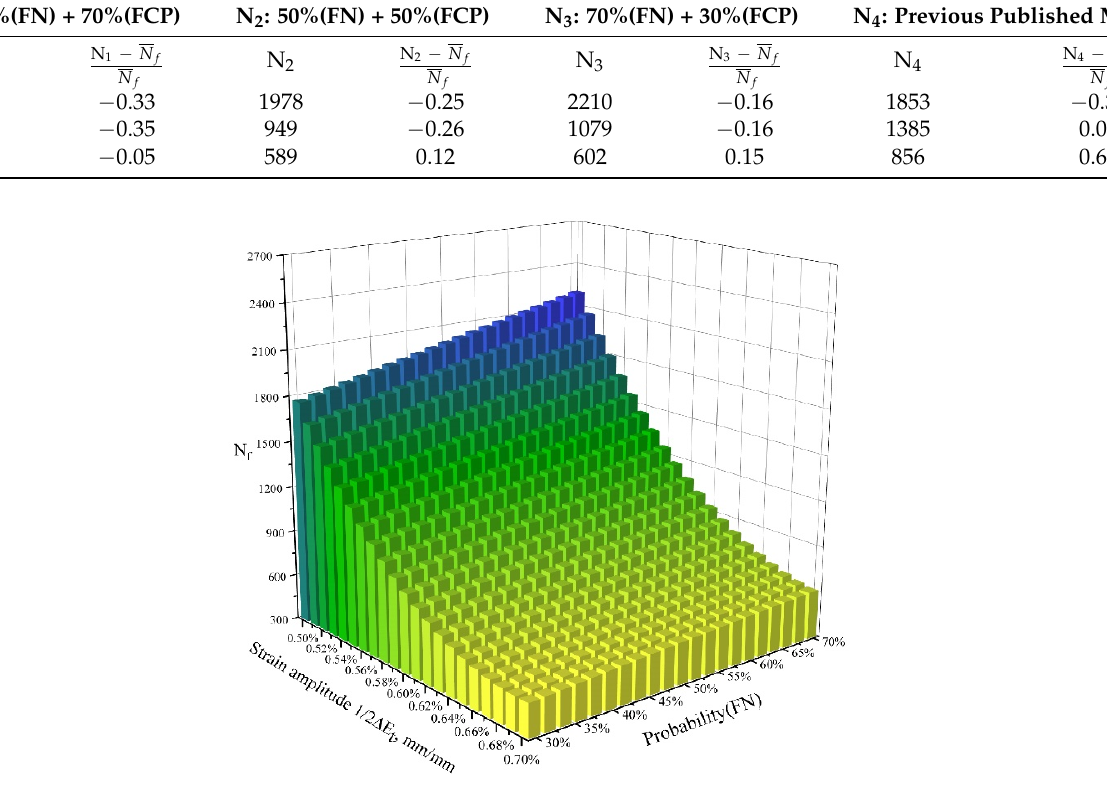
Figure 18. Comparisons between the experiments, predicted results using the proposed method under different probability combinations, and a previously published method based on the crystal plasticity (CP) theory. Table 5. Tested LCF lives of the UFG AA6061 vs. the predicted results considering only one FIP.